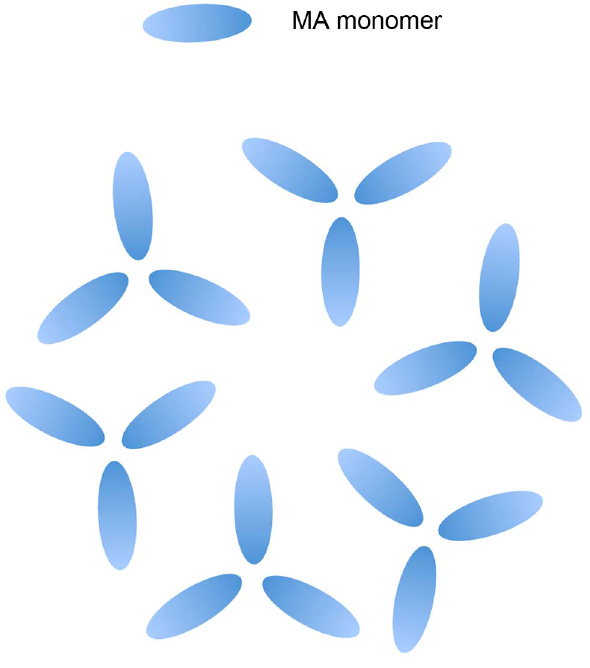
Figure 1. Schematic of MA on an artificial PI(4,5)P 2 containing membrane. MA arrangement as a hexamer of trimers based on the data published in Alfadhli et al. (2009) [35].